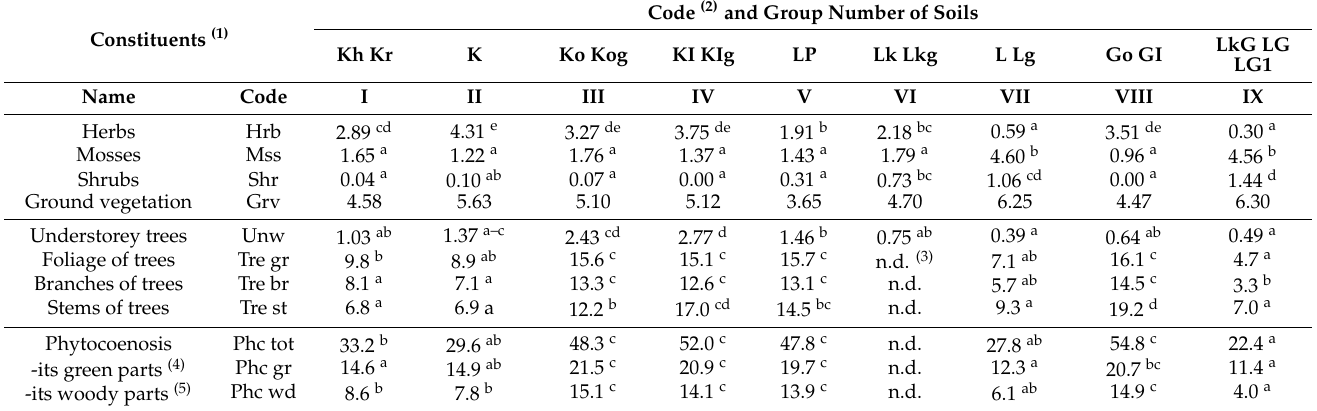
Table 4. Annual increases (AI) of organic carbon (10 − 1 Mg OC ha − 1 yr − 1 ) in different aboveground constituents of forest phytocoenoses.